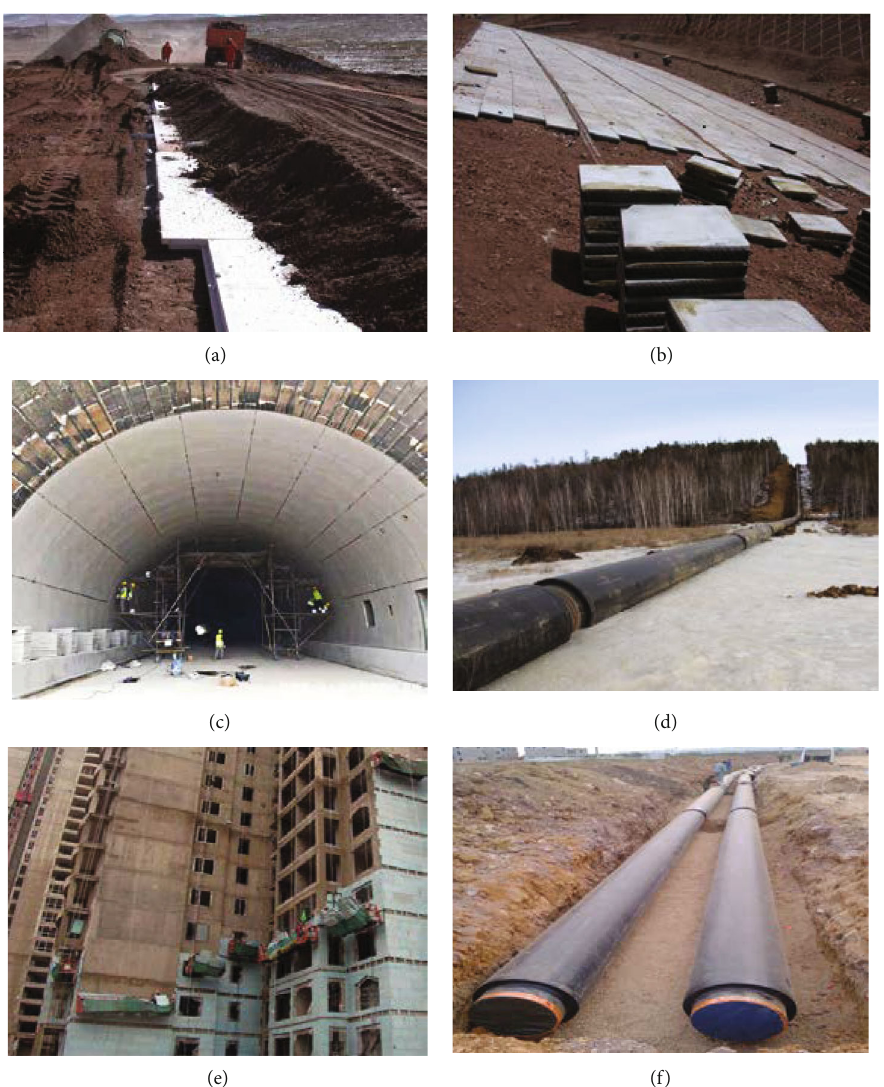
Figure 1: TIMs used in (a) roadway embankment, (b) cutting slopes, (c) tunnels, (d) oil pipelines, (e) buildings, and (f) municipal pipelines in cold